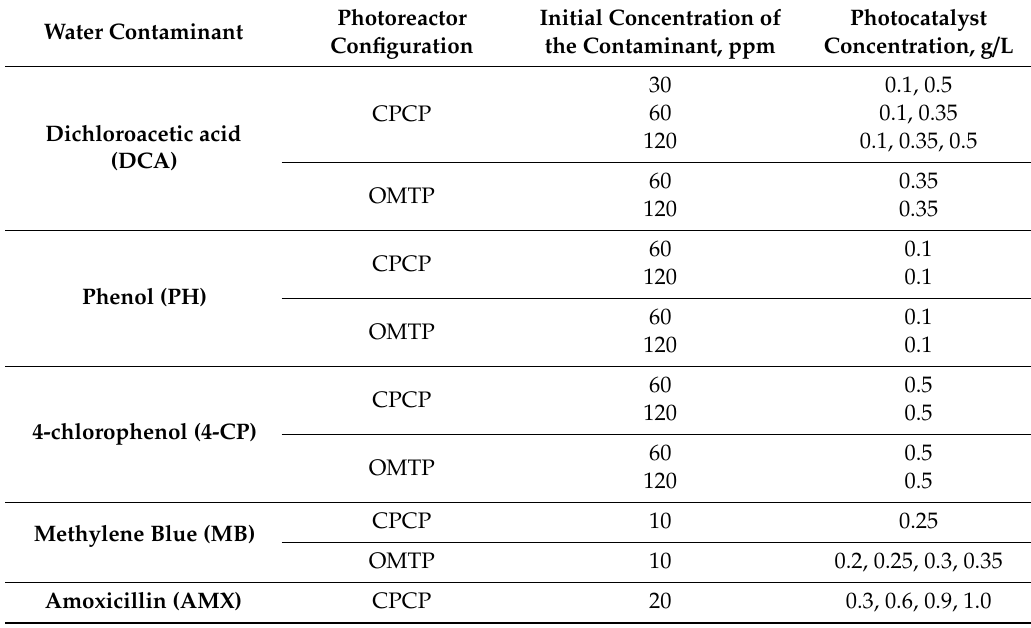
Table 3. PHOTOREAC database of the solar photodegradation of water contaminants. Water